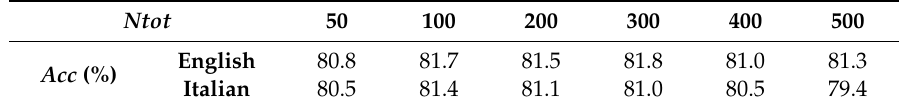
Table 11. Testing accuracy obtained by di ff erent numbers of filters 1 .